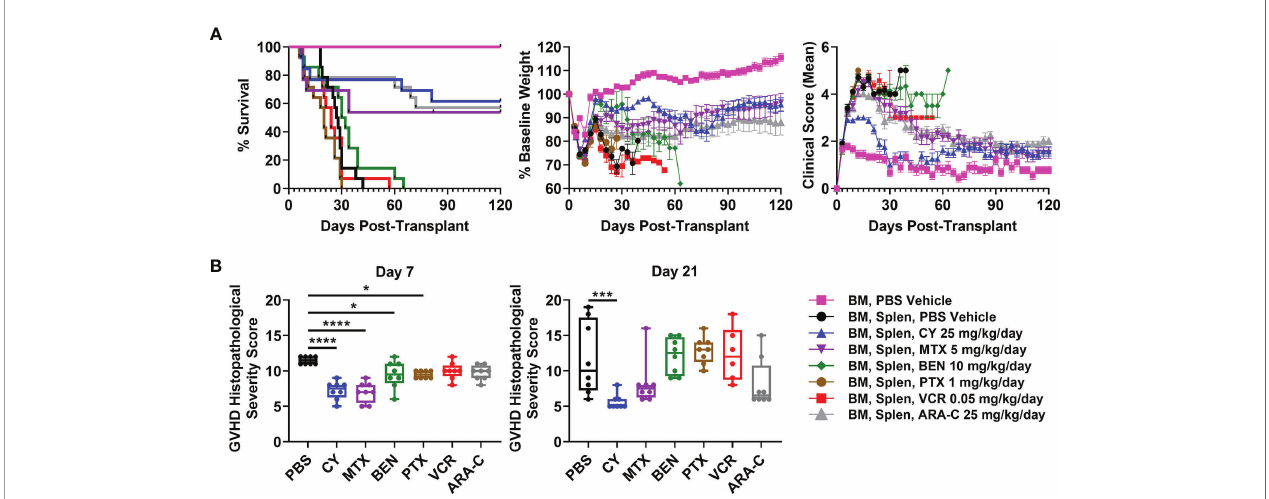
FIGURE 2 | Post-transplantation cyclophosphamide (PTCy), MTX, and ARA-C all are partially effective in mitigating severe GVHD with PTCy having the most ef fi cacy. Mice were transplanted as in Figure 1 and were given either PBS or the previously determined optimal dose of one of the tested chemotherapeutics. (A) CY (HR 0.12, p = 0.0008), MTX (HR 0.28, p = 0.012), and ARA-C (HR 0.11, p = 0.0004) all signi fi cantly prolonged survival compared with vehicle-treated mice, whereas PTX led to more rapid mortality (HR 2.42, p = 0.038). MTX and ARA-C had similar survival compared with CY, but BEN (HR 6.86, p = 0.0008), PTX (HR 8.41, p =